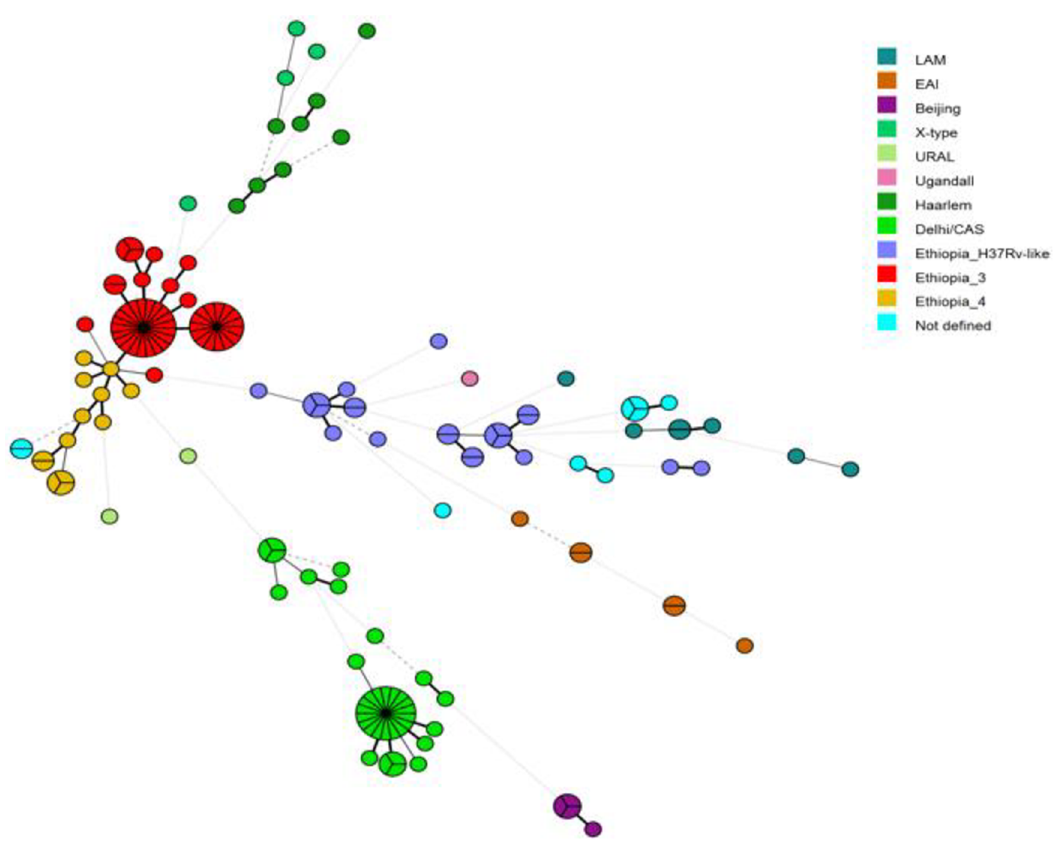
Fig 1. Minimum spanning tree based on 24-loci MIRU-VNTR profiles of 160 MTBC isolates from Eastern Ethiopia. The identified sub-lineages are color-coded. Branch lengths are proportional to number of MIRU-VNTR loci differences between two nodes ( < 1 locus, solid thick lines; 2–3 loci, solid thin lines; > 4 loci, dashed line). Node size is proportional to the number of isolates with identical MIRU-VNTR profiles. EAI: East Africa India, LAM = Latin American